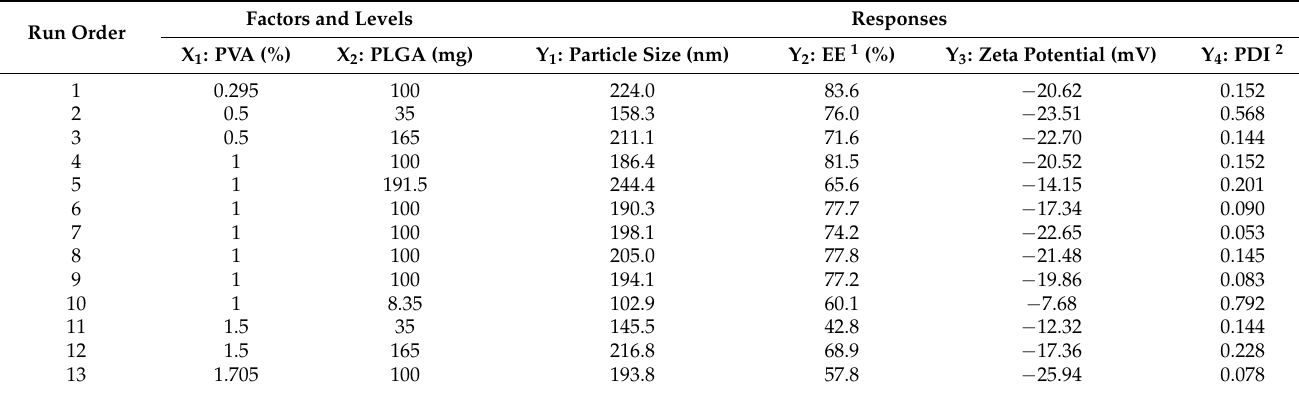
Table 1. Experimental design and response of